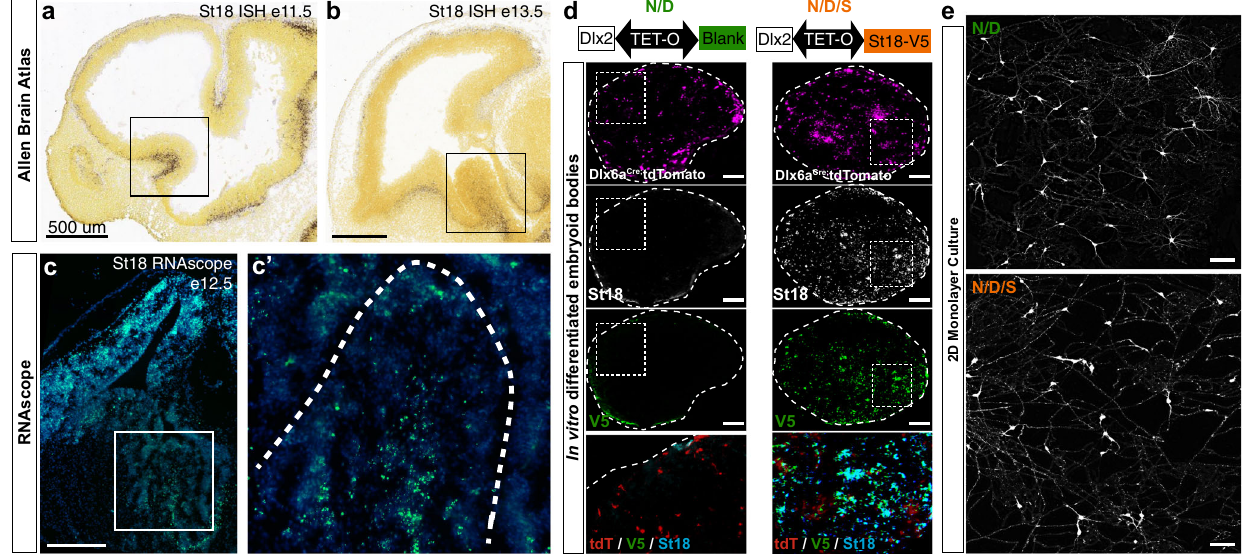
Fig. 1 | St18 expression in the MGE and St18 GOF in in vitro model of MGE development. a E11.5 and b E13.5 parasaggital brain in situ for St18 (Allen Brain Atlas).MGEindicatedbyboxedareas. c E12.5coronalbrainRNAscope(green;DAPI blue) for St18, MGE indicated by boxed area, shown in higher power in ( c ’ ). d SchematicoftranscriptionalGOFinN/DandN/D/Sconditions.N/DandN/D/SES celllinesaredifferentiatedover12daysintoEBs.SectioneddifferentiatedEBsfrom